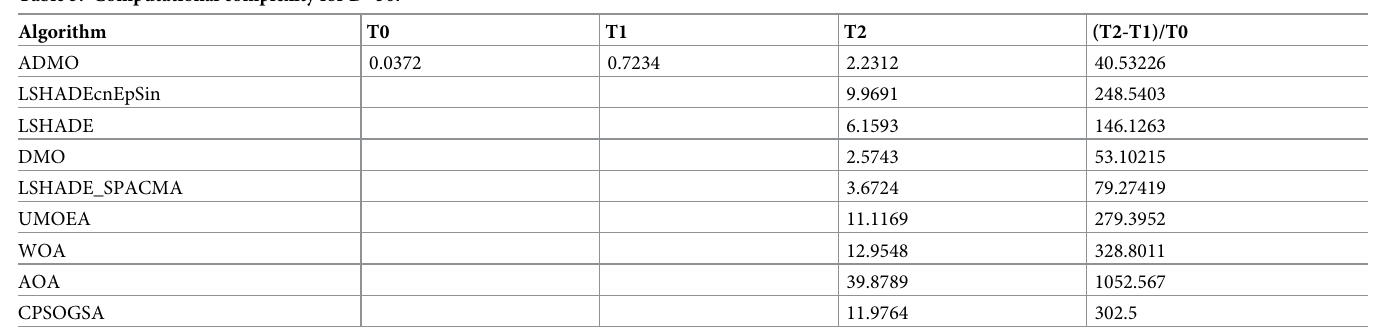
Table 3. Computational complexity for